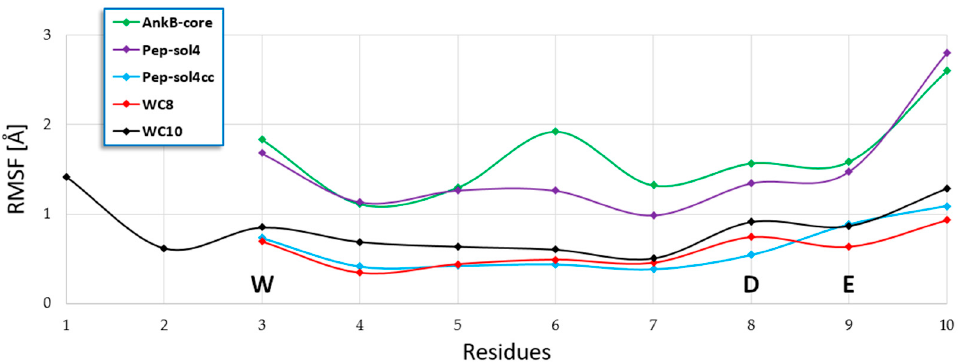
Figure 2. RMSF plots of AnkB-core analogs. Backbone atoms were considered in these calculations. The residues shared by all peptides are highlighted by capital letters.